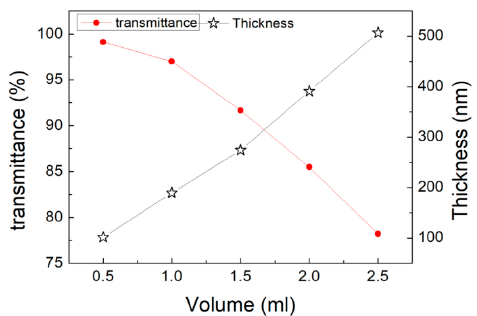
Figure 3. The relationship among transmittance, thickness and amount of silver nanowires ink.